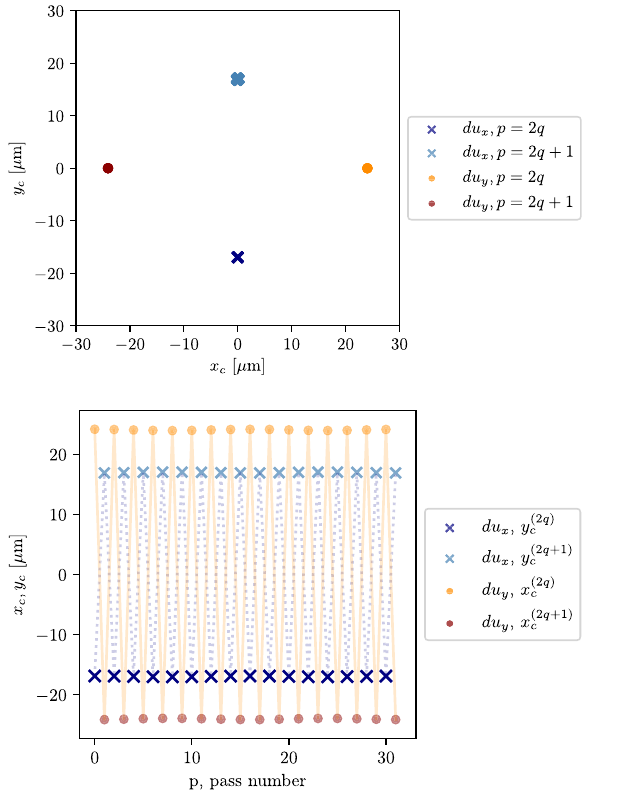
FIG. 26. Top: Simulation of the effect of a horizontal paral- ¼ 7 . 16 μ rad and ∼ 10 μ m of the MPS11 and MPS13 in the local lelism default d ϵ x x referential of the MPS. Bottom: The circulating trace resulting from a parallelism default on MPS13, where p is the path number and q ∈ ½ 0 ; 16 (cid:4) .